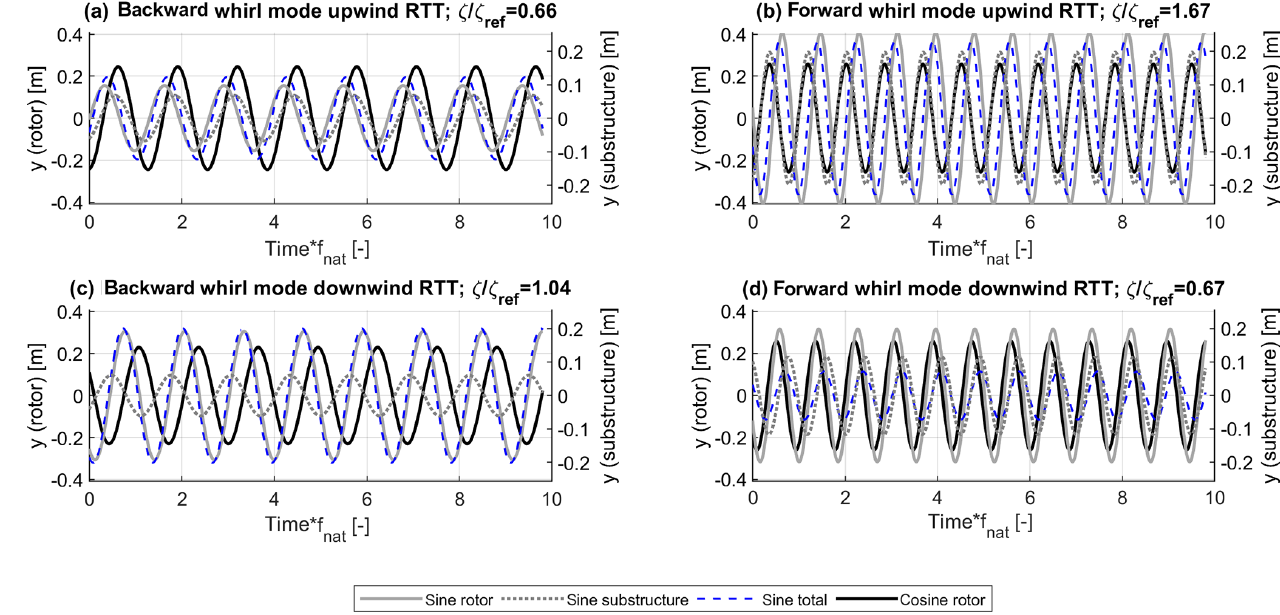
Figure A1. Modal out-of-plane displacements at 9ms − 1 and a shaft length factor of 2 for the backward whirl mode and forward whirl mode of the upwind RTT and downwind RTT configurations. The time axis is normalized with the blade edgewise natural